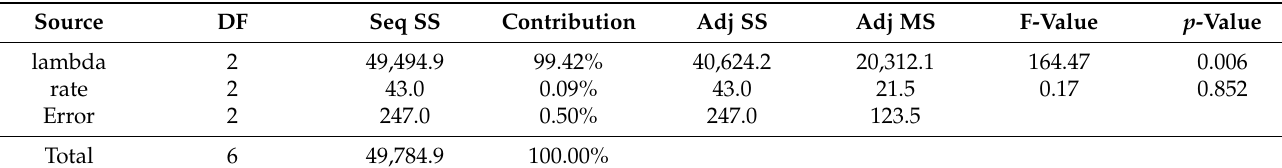
Table 14. ANOVA of HAZ hardness with respect to the lambda and rate explanatory